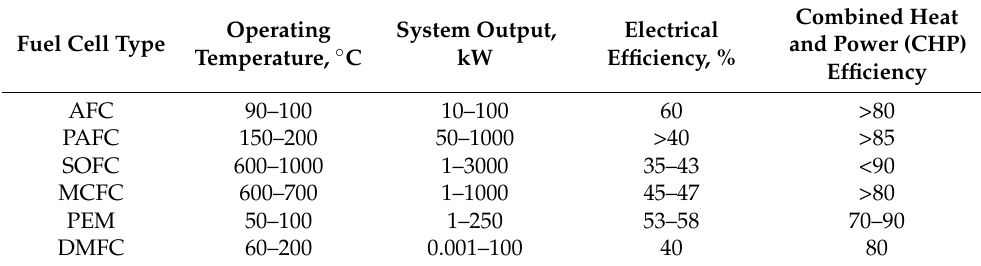
Table 1. Properties of the fuel cells, prepared on the basis of [133].